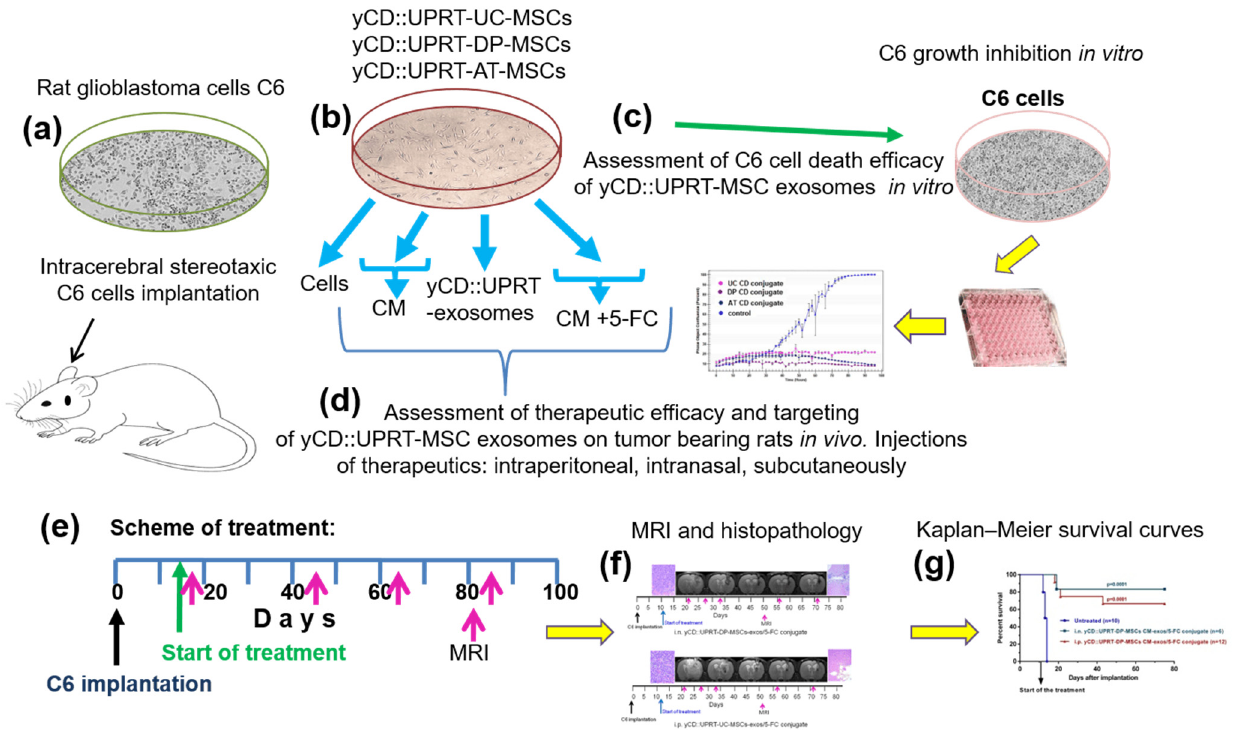
Figure 1. Schematic overview of steps performed in the study. ( a ) Rats were injected with a dose of 5 × 10 5 or 1 × 10 6 C6 cells intracerebrally by a stereotaxic technique. ( b ) Sources of therapeutic materials tested were: Cells, CM with yCD::UPRT-MSC-exosomes, and yCD::UPRT-UC-MSC-exos/5-FC conjugate from the umbilical cord, dental pulp, and adipose tissue MSCs, stably transduced with yCD::UPRT gene. ( c ) The course of growth/inhibition was monitored and evaluated by the IncuCyte system. ( d ) Therapeutic efficacy and targeting assessment of different forms of therapeutic materials applied i.n., i.p., or s.c. in rats intracerebrally bearing C6 glioblastoma ( e ) Scheme of treatment. ( f ) Evaluation of therapeutic outcomes by MRI and final histopathology ( g ) Survival of treated animals evaluated in Kaplan–Meir survival curves.